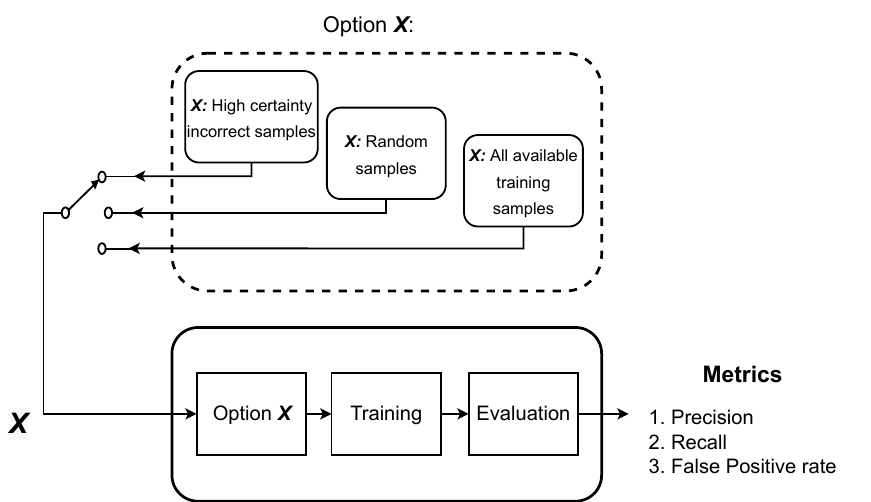
Figure 6. Illustration of options used to evaluate the feedback of high certainty incorrect samples.